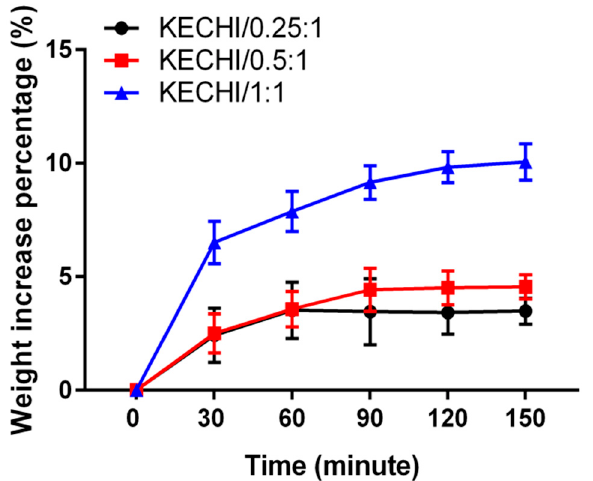
Figure 3. Fluid absorption of keratin-chitosan membranes immersed in pH 7.4 PBS solution.